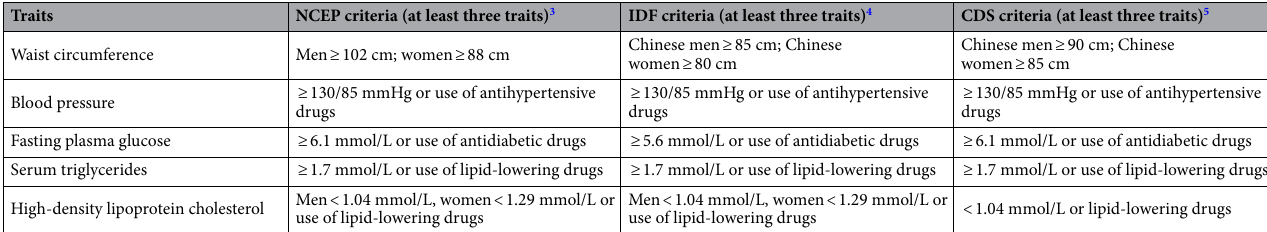
Table 1. Three sets of defining criteria for the metabolic syndrome. NCEP National Cholesterol Education Program, IDF International Diabetes Federation, CDS Chinese Diabetes